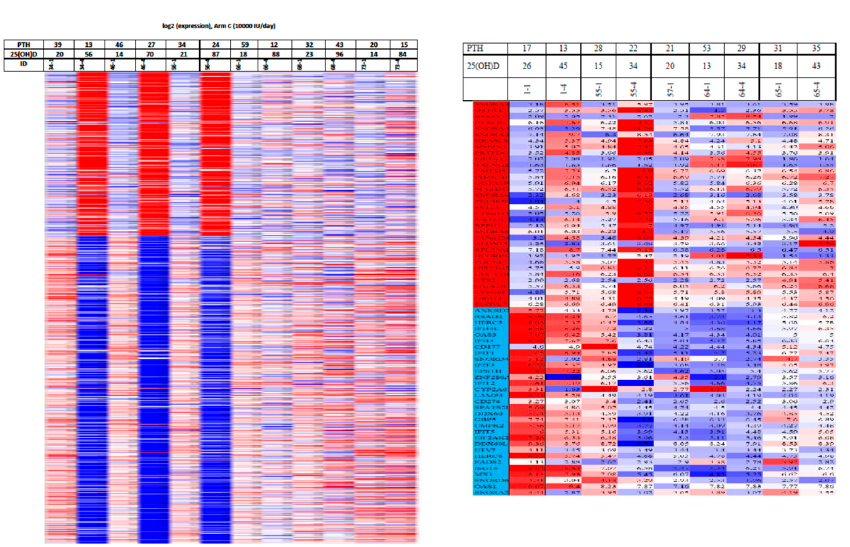
Figure 14. ( Left ) Heatmap of 1289 vitamin D-responsive genes whose expression response variation in 6 vitamin-D-deficient subjects taking 10,000 IUs per day of vitamin D 3 for 6 months, showing